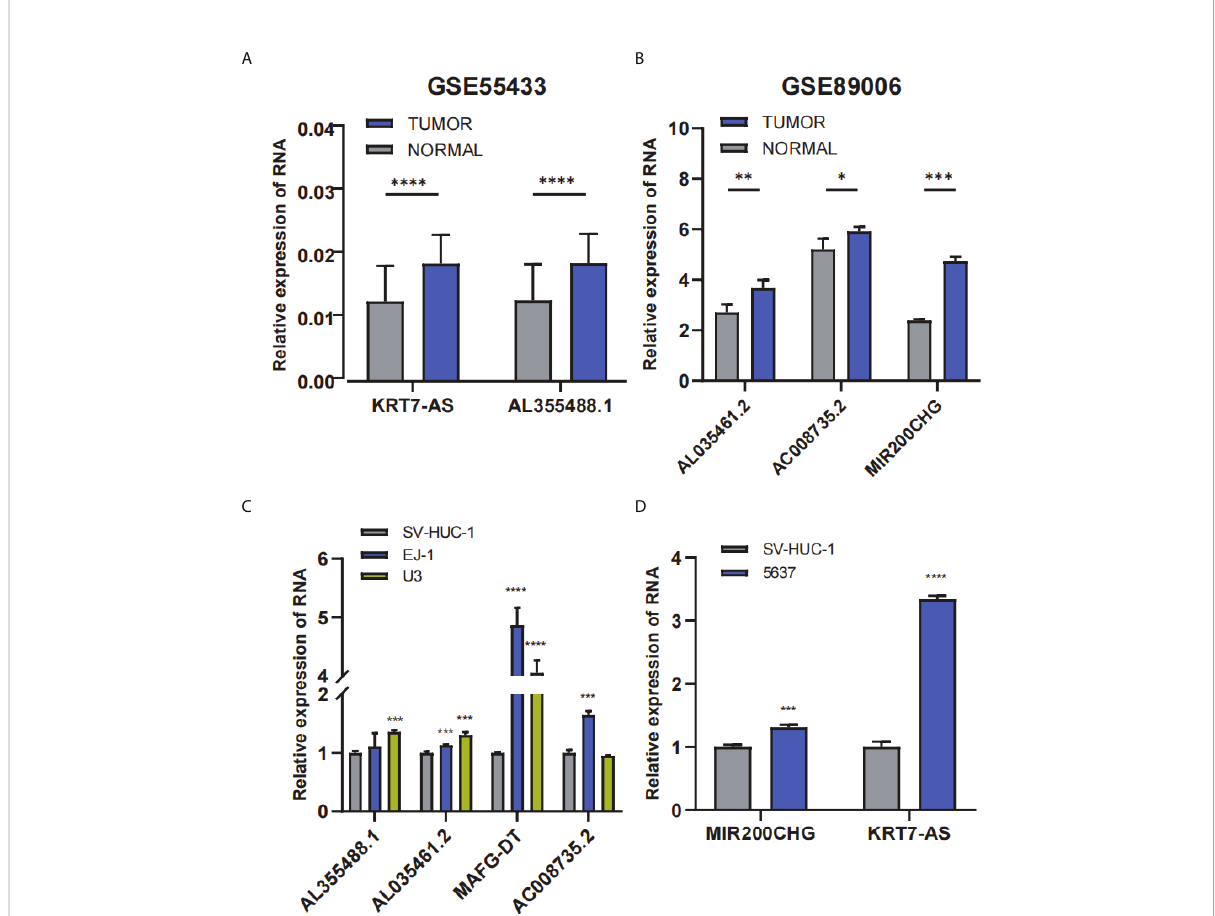
FIGURE 9 The expression pro fi le of the 6-lncRNAs signature with external validation. (A, B) The lncRNA expression pro fi le in GSE55433 and GSE89006 datasets, respectively. (C, D) The lncRNA expression level in bladder cancer cells and normal cells. *p < 0.05; **p < 0.01; ***p < 0.001; ****p <